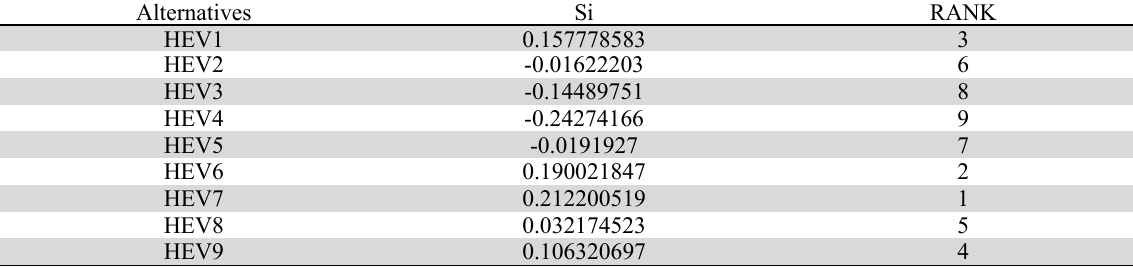
Entropy-MABAC based performance score and relative rank of the alternatives Alternatives